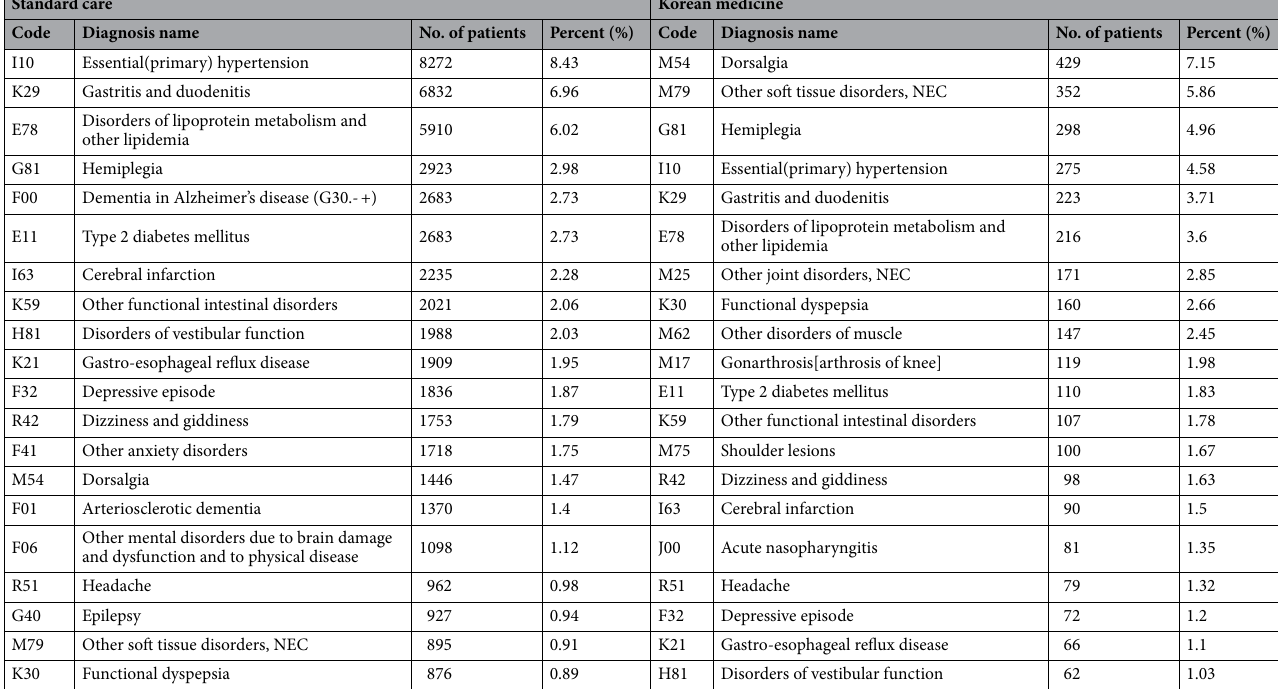
Table 4. Comorbidities of patients with different diagnosis